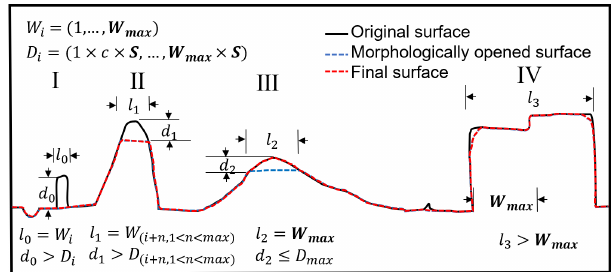
Figure 2. Illustration of the SMRF filtering process in a simplified urban environment with artefacts (I and IV) and hills (II and III). The symbols are as follows: W : window size; D : difference thresh- old; c : cell size ( c equals 2m in this case); S : slope threshold; l: patch size of the elevated areas.